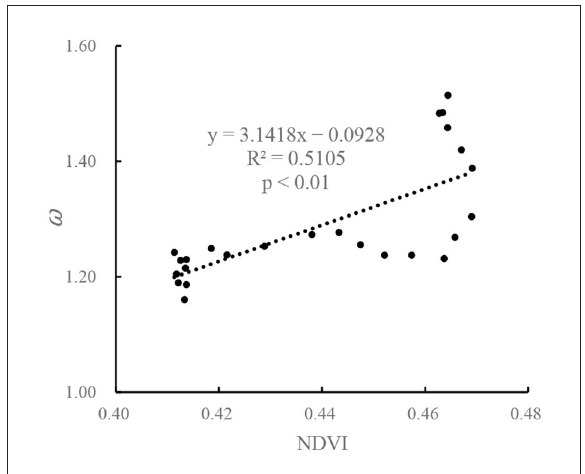
FIGURE5 The functional relationship between Normalized Difference Vegetation Index (NDVI) and Budyko parameter ( ω